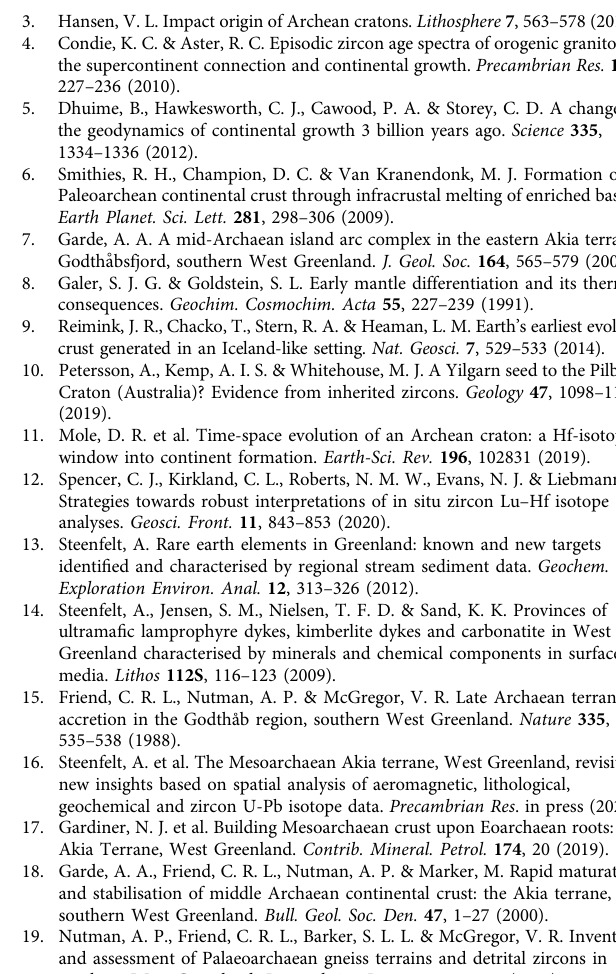
Fig. 7 Pressure – temperature diagram depicting the melting of mantle peridotite and a schematic representation of the implication of this process for ancient crust. a Pressure – temperature diagram showing location of the solidus and various melt isopleths during dry melting of mantle peridotite modi fi ed after ref. 39 , along with adiabatic convective geotherms for mantle potential temperatures of 1300, 1400, 1500, and 1600 °C (after McKenzie and O ’ Nions 69 ). Overall, increasing mantle potential temperatures result in greater melting depth and greater melt fractions. Opx denotes Orthopyroxene. b Cartoon section depicting the production of Mesoarchean mantle-derived melts, which penetrate and modify pre-existing crust and generate new TTG (tonalite – trondhjemite – granodiorite). Ancient crust serves as buoyant life-rafts that facilitate rapid crustal growth during the Mesoarchean and Neoarchean and are also preferentially preserved relative to solely juvenile